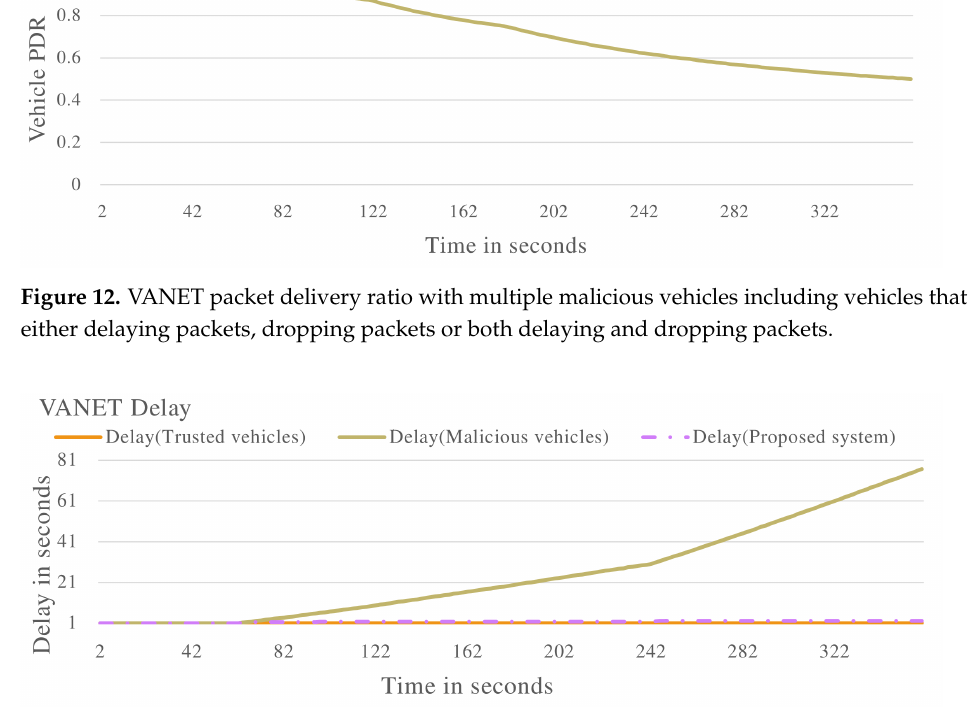
Figure 13. Vehicles delay multiple malicious vehicles with multiple malicious vehicles including vehicles that are either delaying packets, dropping packets or both delaying and dropping